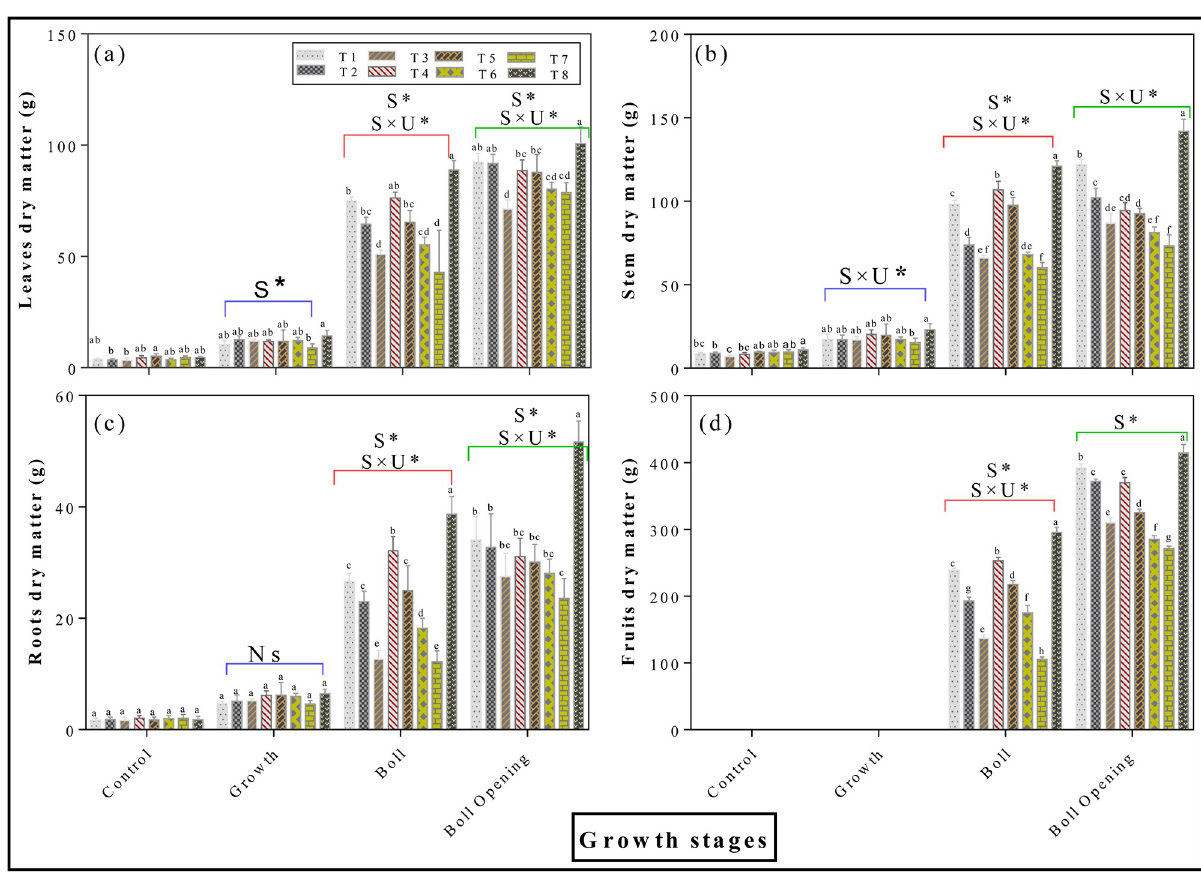
Fig 4. Effects of round irrigation methods on dry matter accumulation: Fig (3a) represents leaves dry matter; Fig (3b) represents stem dry matter; Fig (3c) represent roots dry matter; and Fig (3d) represent fruits dry matter, respectively. Data were presented as the mean ± standard error (SE) of three replicates at a significance level of p < 0.05. The inserted P values are from two-way ANOVAs.